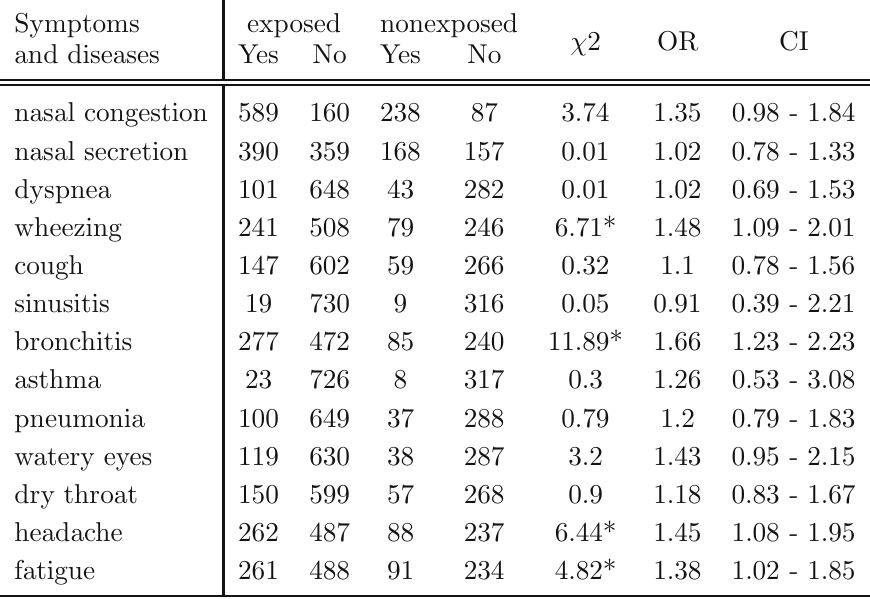
Table 5 Exposure to ETS and its influence on children’s health.